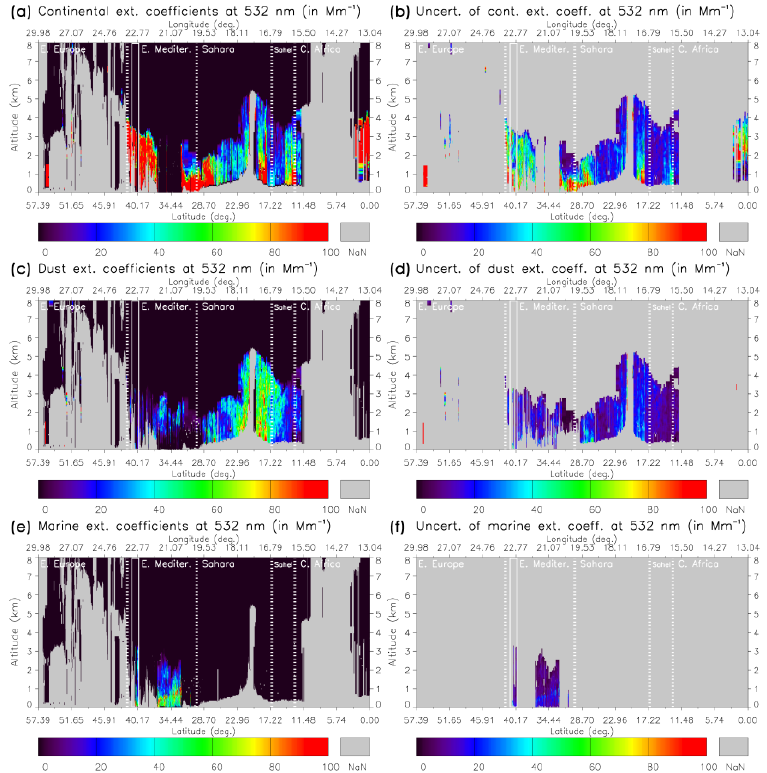
Figure 6. Vertical cross sections of CALIPSO extinction coefficients at 532 nm, and the corresponding uncertainties (using error propagation) for continental (a, b), dust (c, d), and marine aerosols (e, f).